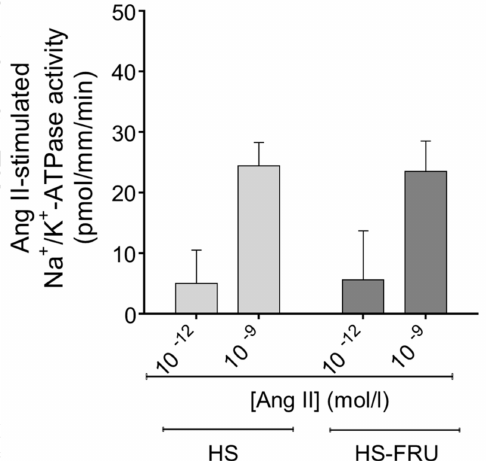
Figure 3. Effect of angiotensin II (Ang II) on Na + /K + -ATPase hydrolytic activity in proximal tubules